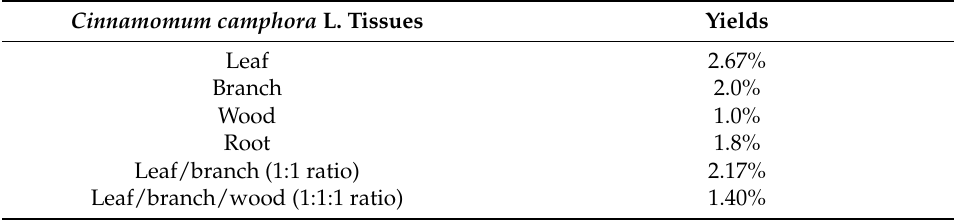
Table 1. Essential oil yields from different tissues of Cinnamomum camphora